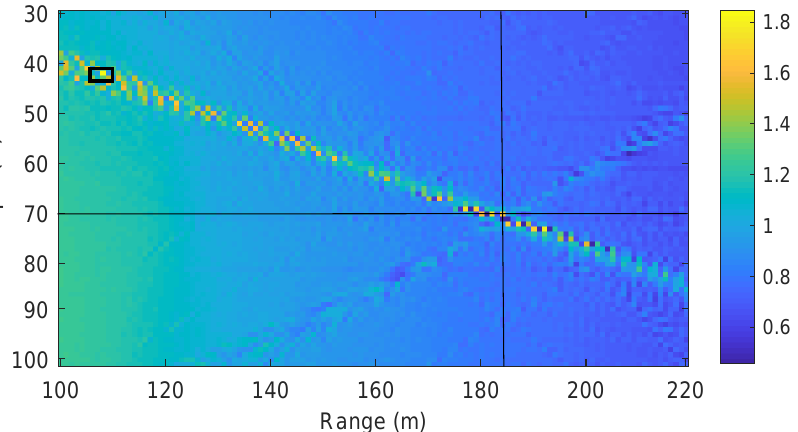
Figure 2. An example of the coherent AF in (6) for the parameters of acoustic environment in Table 1. The crossing point of the horizontal and vertical black lines indicates the true receiver position. The black square indicates the position estimate (the AF maximum). Here we use the acoustic environment with the uniform SSP as shown in Figure 3.